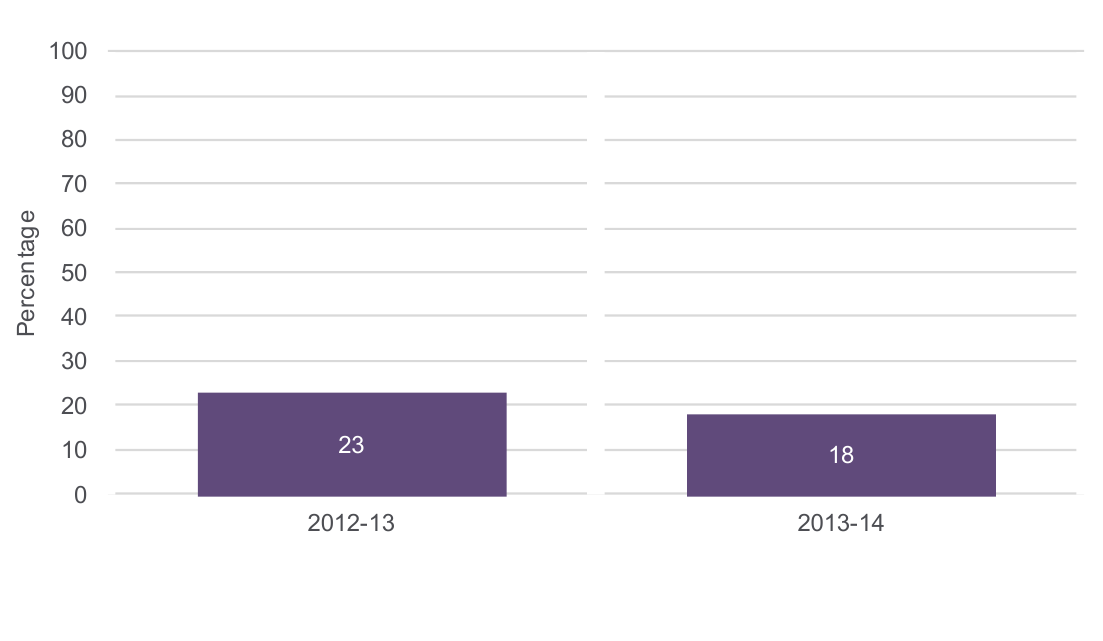
Figure 4: Whether people were involved in social action in their local area at least once in the last year, 2012-13 to